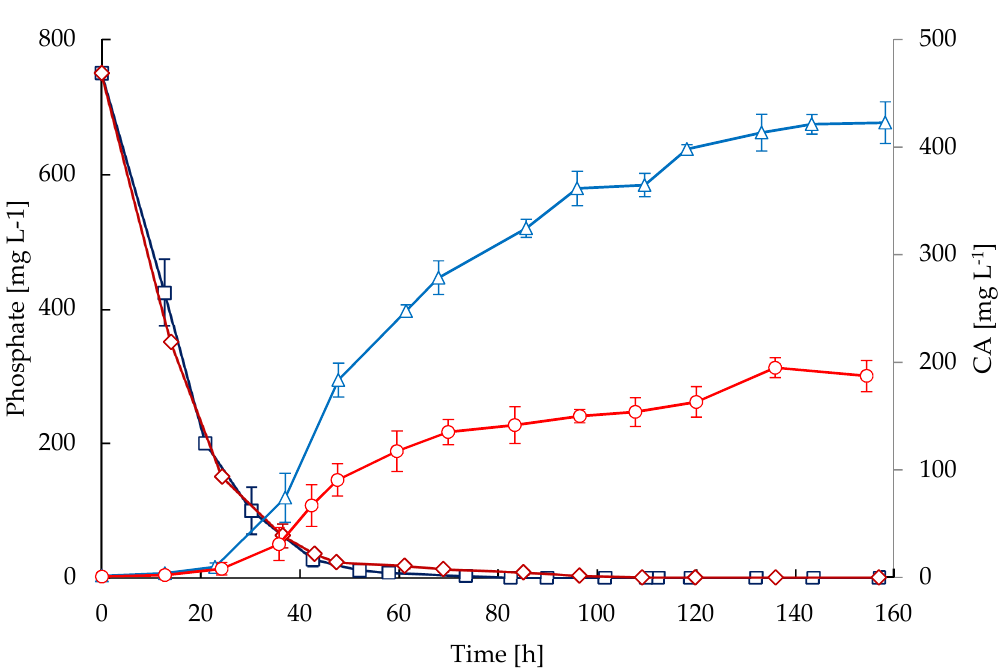
Figure 5. Time courses of clavulanic acid (CA) and phosphate in fed-batch cultivations of S. clavuligerus. CA in STR (triangles) and CT (circles), phosphate in STR (squares) and CT (diamonds).